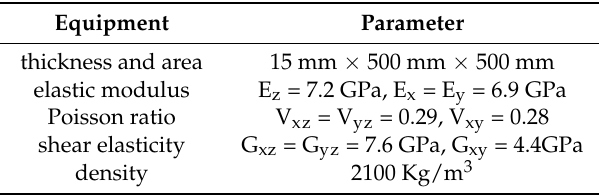
Table 1. Parameters of composite